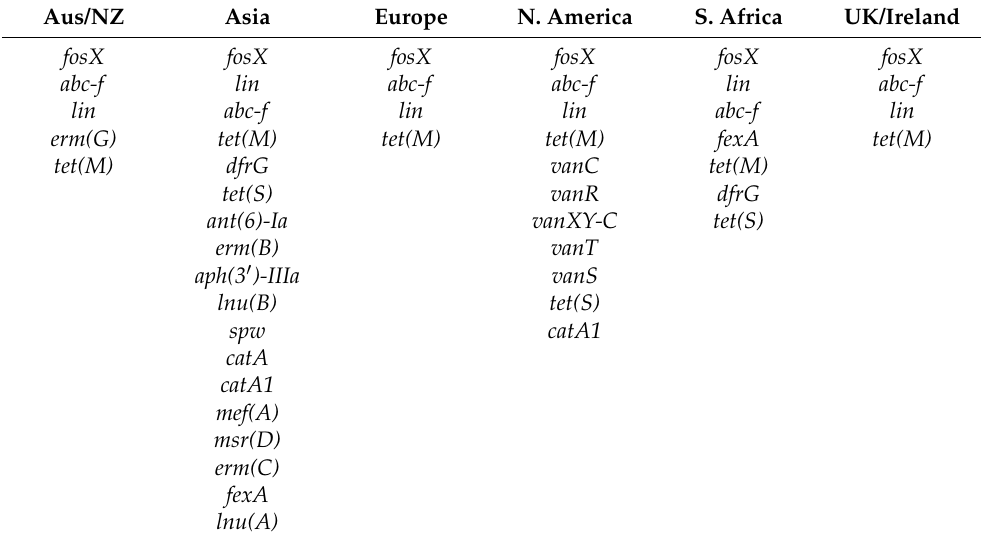
Table 3. Highly occurring AMR genes by region.